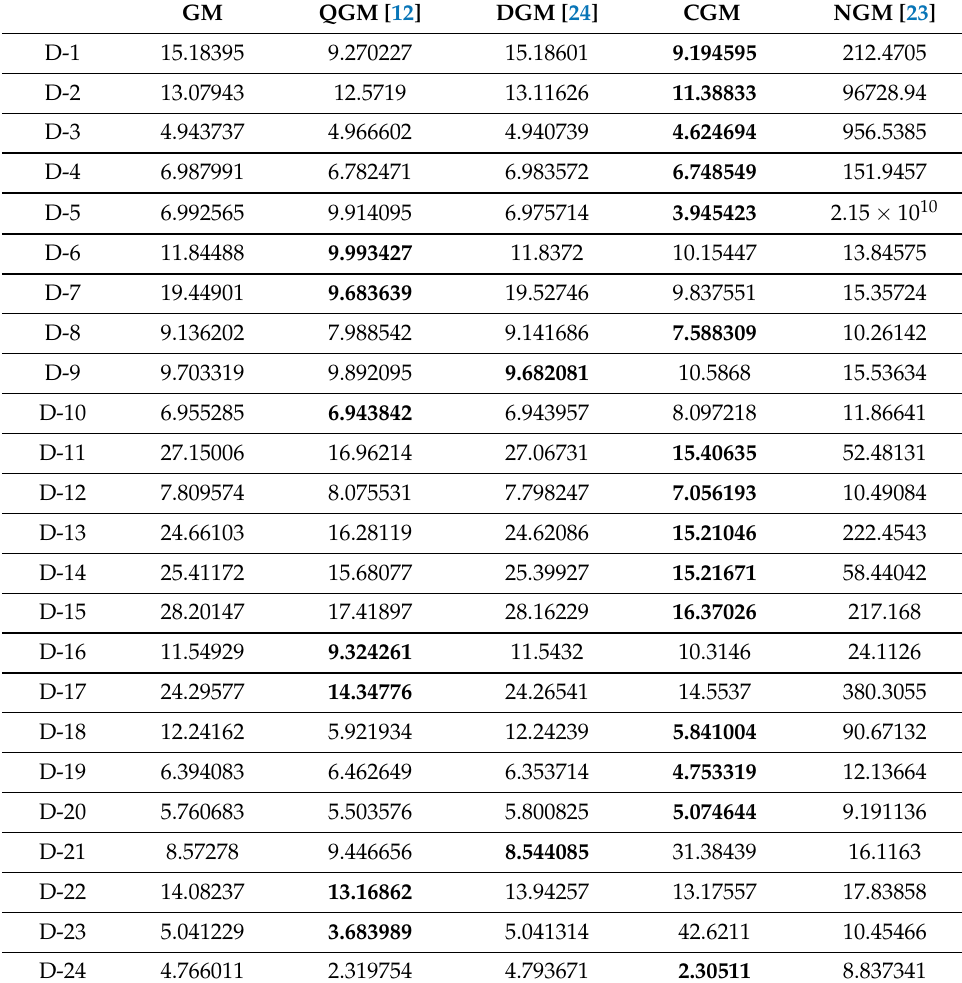
Table 3. MAPE values for all forecasted data